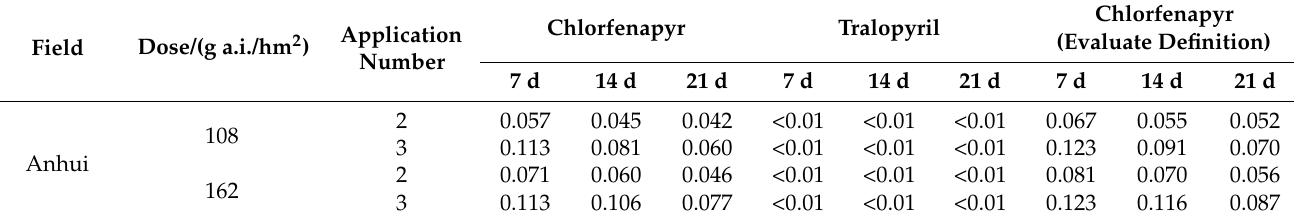
Table 3. Final residues of chlorfenapyr and tralopyril in